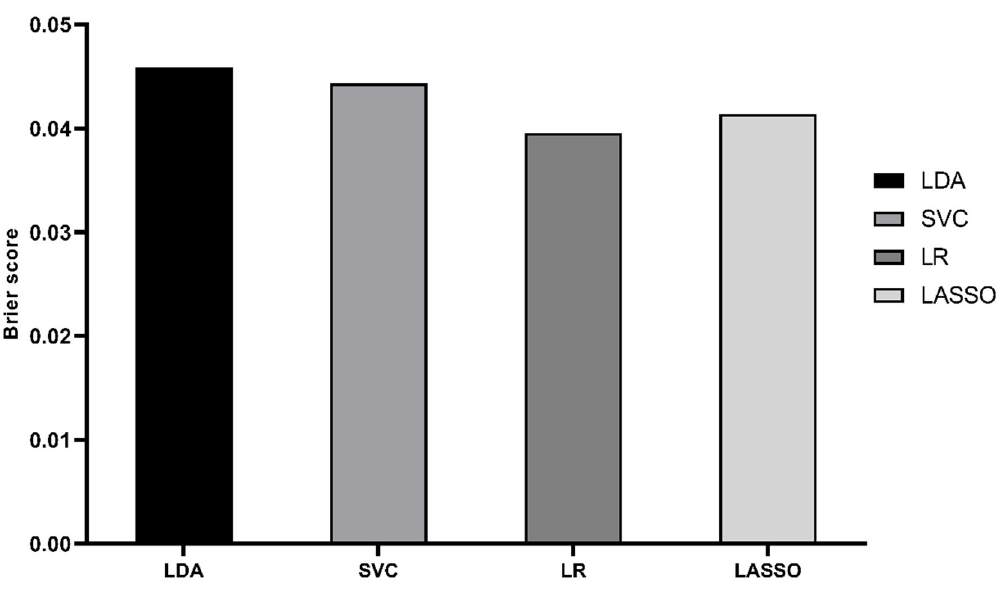
Figure 12. Brier score of nomogram and ML prediction models in testing cohort.